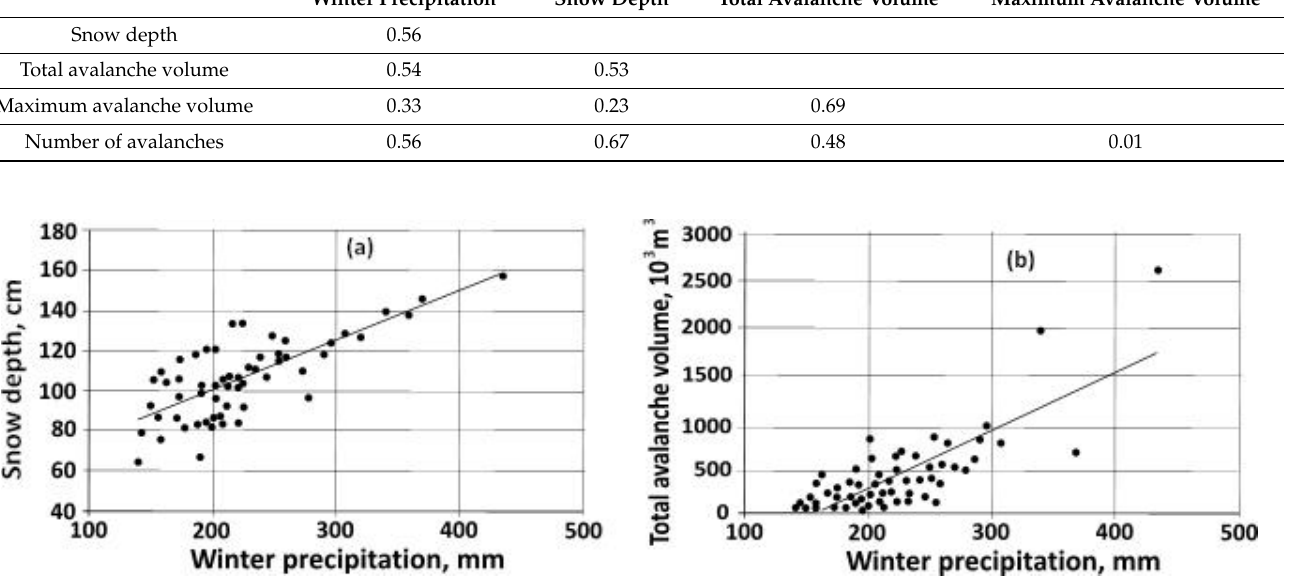
Figure 4. The correlation ( a ) between snow depth and winter precipitation; ( b ) between the total avalanche volume and the winter precipitation.